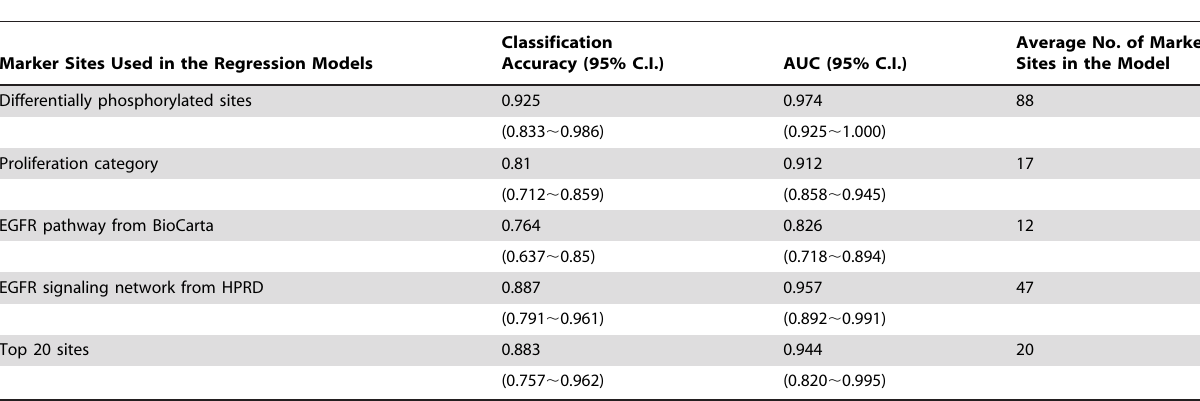
Table 2. The performances of the predictive models for normal/tumor classification.